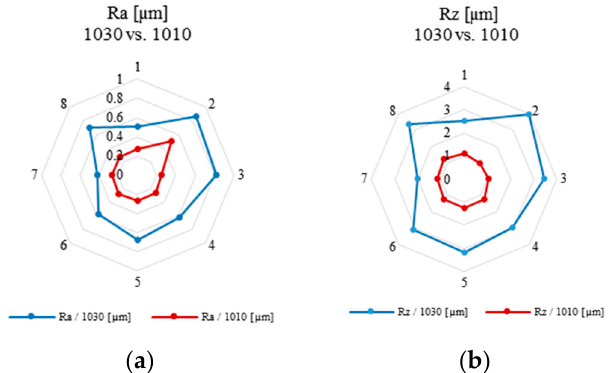
Figure 12. Comparison of achieved surface roughness values after hard machining tests: ( a ) roughness average, Ra; ( b ) roughness depth, Rz.